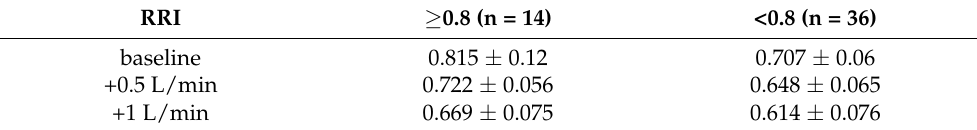
Table 3. Extent of reduction of RRI during enhancement of Impella ® output by mean of 0.5 L/min and 1.0 L/min in the different patient groups (Baseline RRI ≥ 0.8,